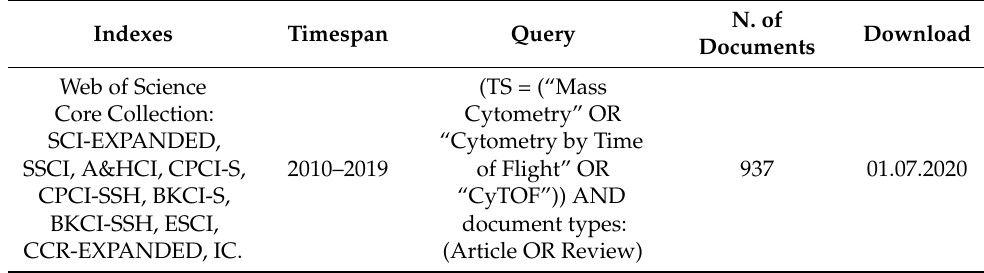
Table 1. Details of dataset search strategy for the identification of mass cytometry papers in